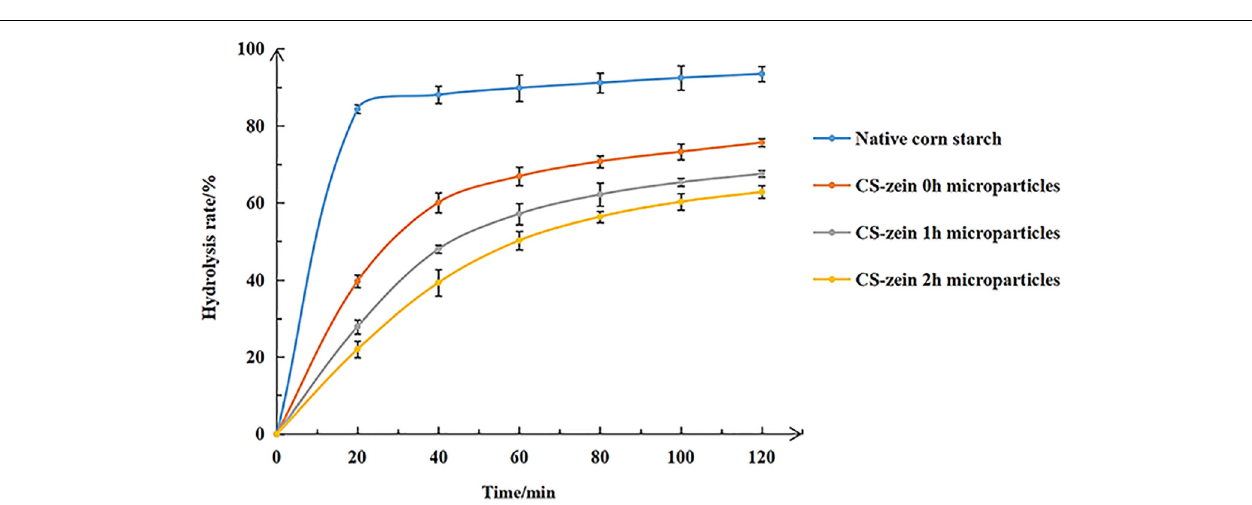
Frontiers in Nutrition |